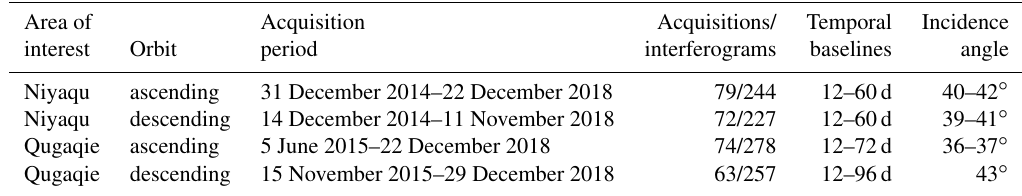
Table 1. Sentinel-1 data used for the time series analysis of both study areas. Area